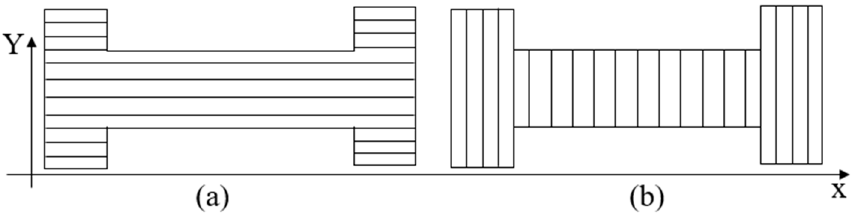
Figure 7. Illustration of dog bone printed in ( a ) X direction and ( b ) Y direction.